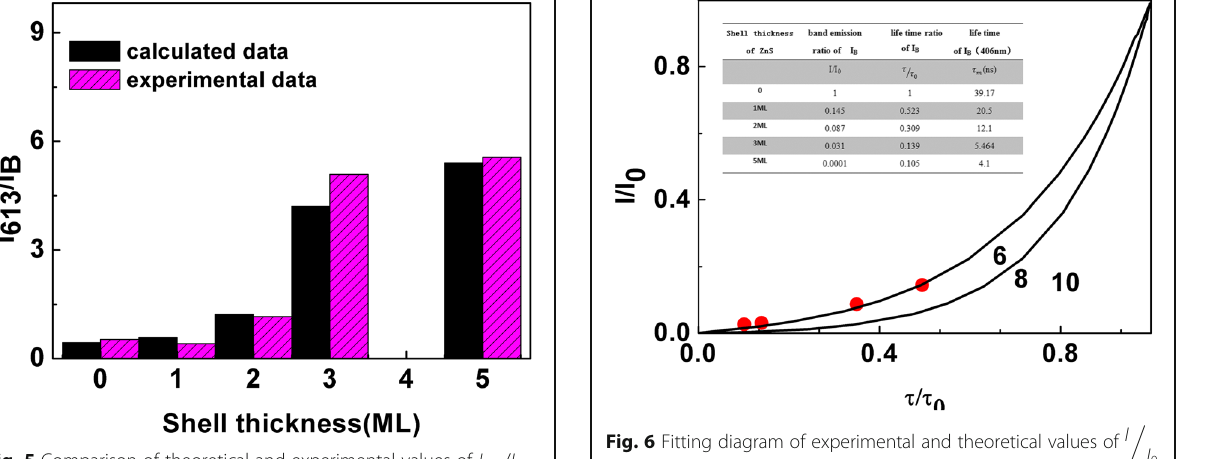
Fig. 5 Comparison of theoretical and experimental values of I 613 / I B of ZnSe:Eu/ZnS core-shell quantum dots with different shell thickness